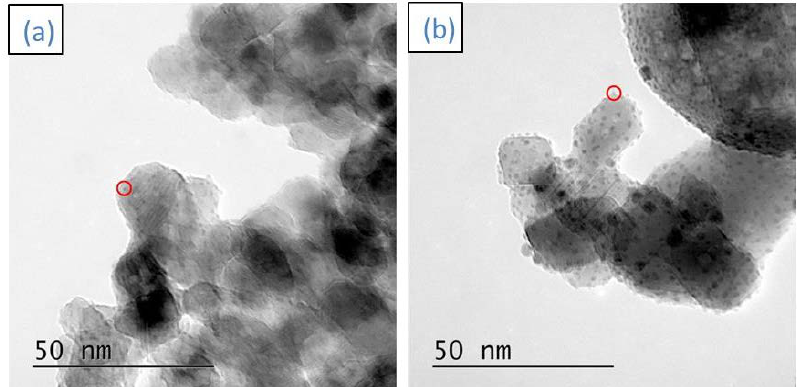
Figure 16. Representative TEM images of 5 wt % AuPd/TiO 2 prepared by supercritical CO 2 anti-solvent method, calcined at ( a ) 450 °C or ( b ) 750 °C. The areas circled in red highlight a metal nanoparticle (Adapted with permission from [84]. Copyright Elsevier, 2015).